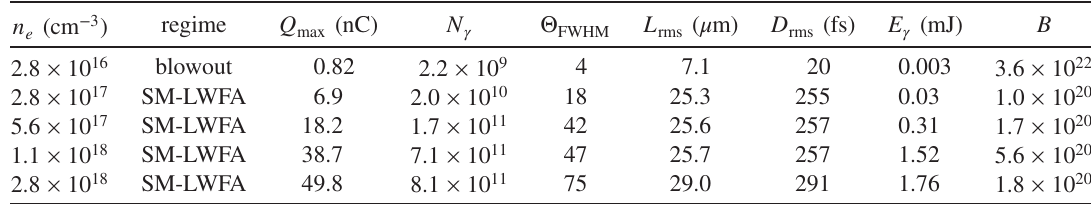
is the transverse rms rms